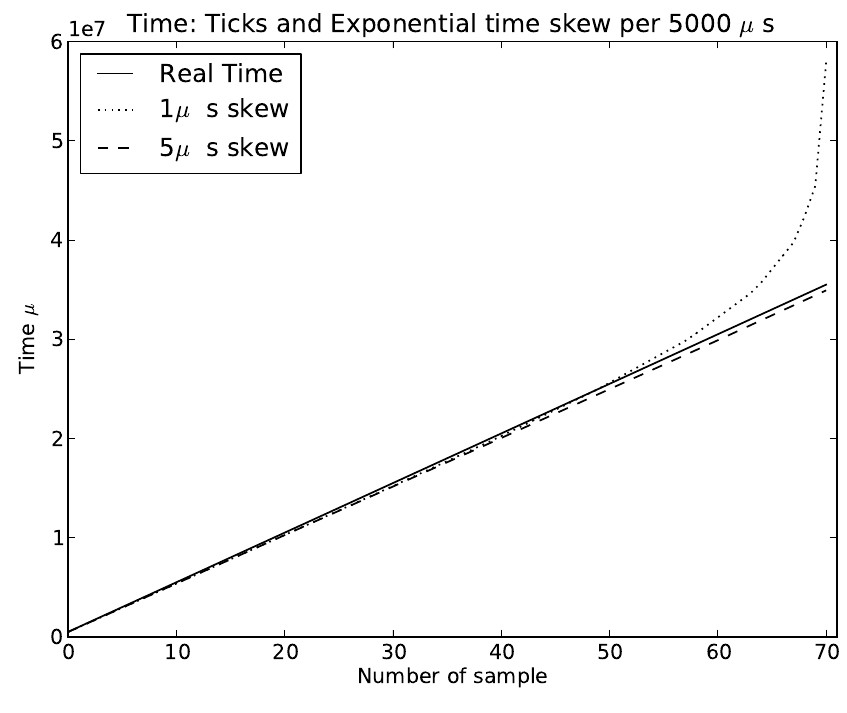
Figure 9. Crystal simulations: Exponential time